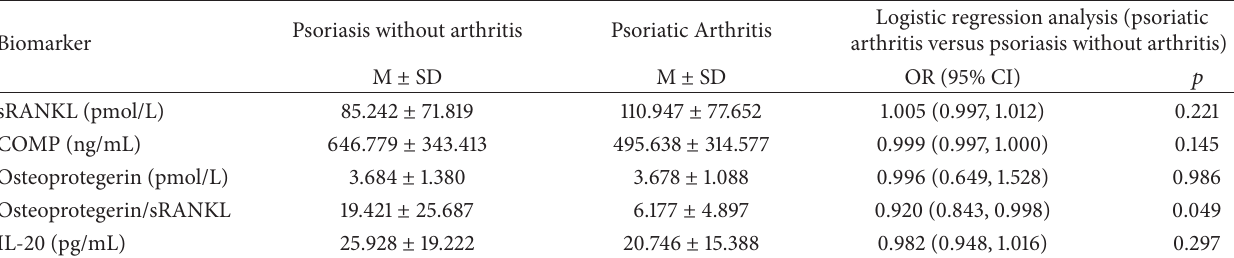
curve for model Area under the curve = 0.8851